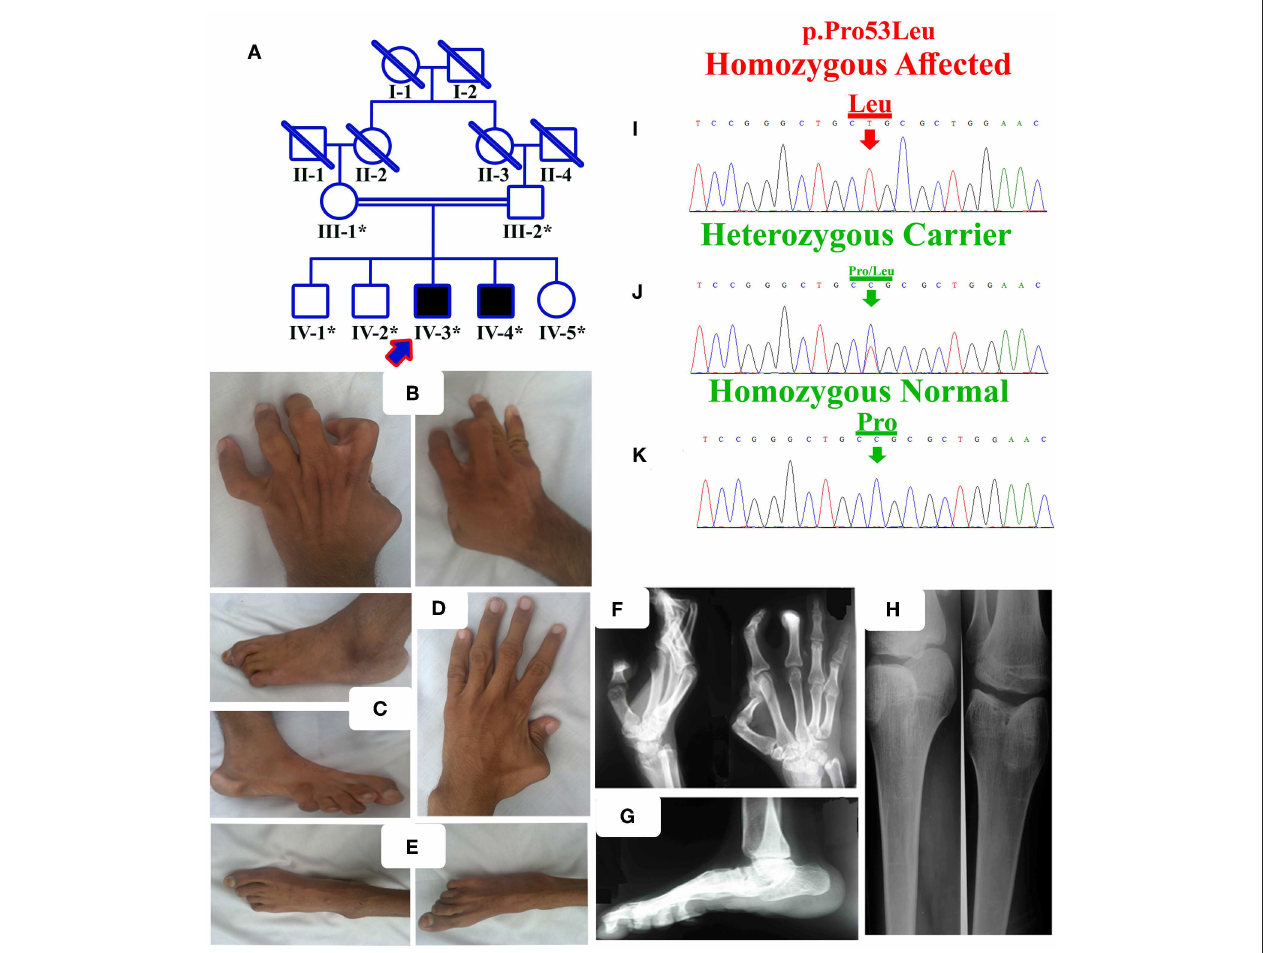
FIGURE 1 | (A) Pedigree of the present family segregating distal arthrogryposis type 5 in autosomal recessive manner. Double lines are indicative of consanguineous unions. The individual numbers labeled with asterisks indicate the samples which were available for this study. (B) IV-3 having bilateral metacarpal and inter-phalangeal extension and flexion contractures. (C) Bilateral metatarsals extension, pes cavus, high arch, talipes varus, and overlapping toes. (D) IV-4 having left hand thumb flexion contracture, while normal right hand. (E) Bilateral metatarsals extension, pes cavus and talipes varus. (F,G) Radiographs of hands and feet of the affected individual IV-3, showing flexion contractures. (H) Both knees slightly flexed, with limited active knee flexion. (I) Sanger sequencing electrograms of the identified mutation, an upper panel showing the mutated nucleotide sequence (c.158C > A; p.Pro53Leu) in a homozygous state in the affected individuals, (J) middle panel showing heterozygous carrier and (K) lower panel showing the homozygous wild-type